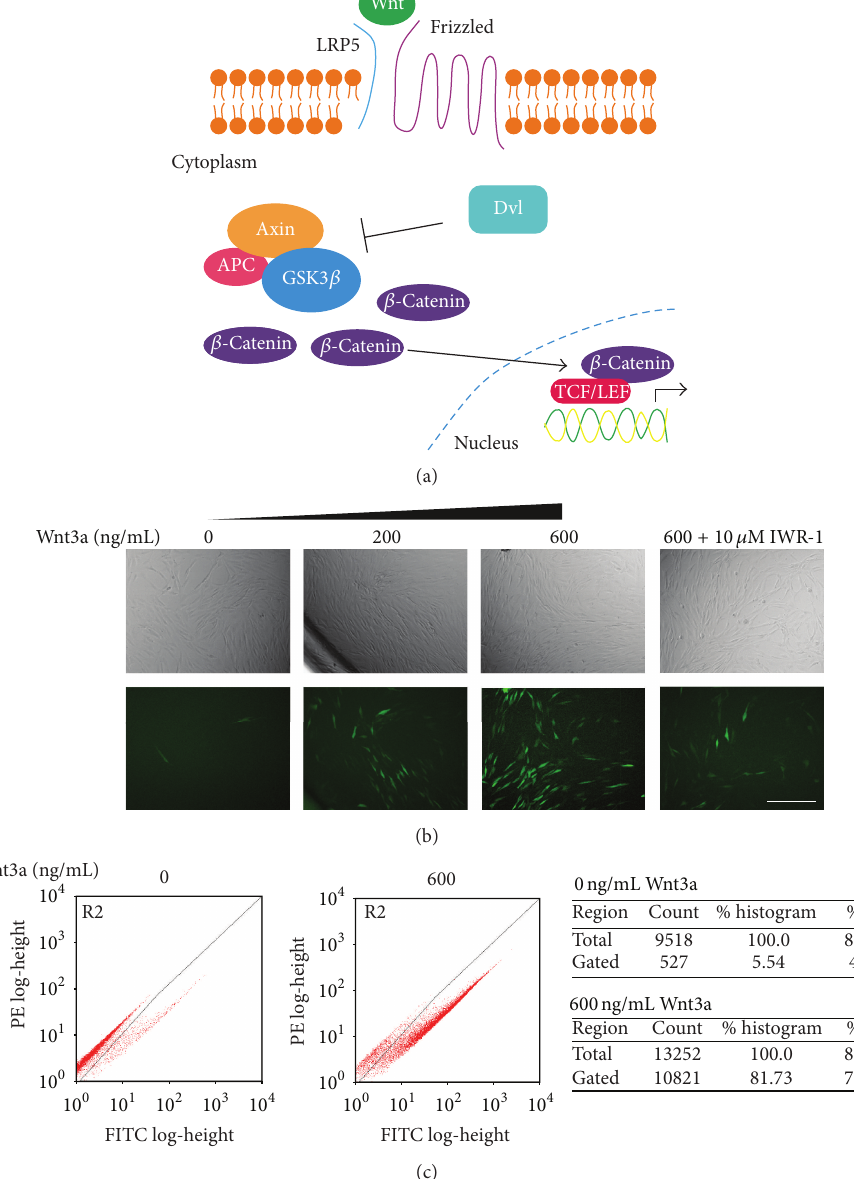
Figure 1: Stimulation using Wnt3a results in observable fluorescence in human Y201 MSC-EGFP reporter lines. (a) Overview of activated canonical Wnt signalling pathway. (b) Fluorescence microscopy of human Y201 MSC-EGFP reporter cells treated with varying concentrations of Wnt3a with or without a Wnt pathway inhibitor, IWR-1. Scale bar = 200 𝜇 m. (c) Flow cytometry scatter plot histograms of Wnt3a-treated Y201 Wnt EGFP reporters versus untreated, after removal of dead cells and debris by gating. Shift in population away from autofluorescence indicates positive EGFP expression (lower right